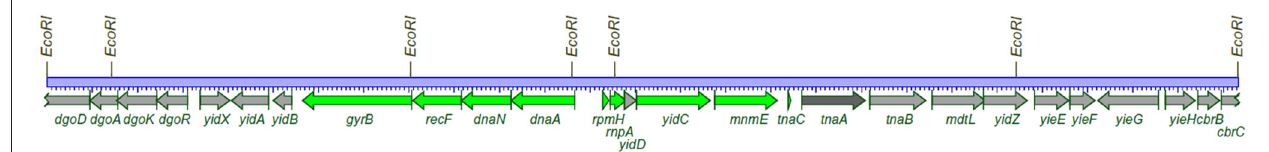
FIGURE 2 | The dnaA region of the E. coli chromosome. 26,332 bp between the outmost Eco RI sites is the chromosomal DNA present on two λ tna phages ( λ tna 552 and λ tna 530). The drawing is based on the published complete E. coli sequence version (acc.no. U00096.2). The genes (proteins) stained green are those that could be identified on SDS-polyacrylamide gels. The light gray proteins and the dark gray protein encoded by the tnaA gene were not visible (Hansen and von Meyenburg, 1979; Ream et al., 1980).